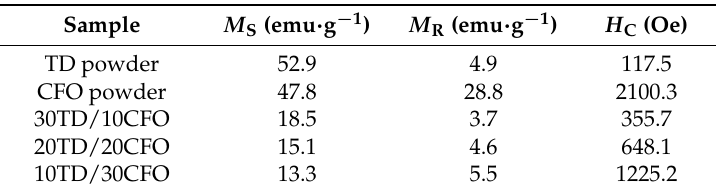
Table 1. Magnetic properties (magnetization saturation at 5000 Oe: M S ; remanent magnetization: M R and coercive field: H C ).